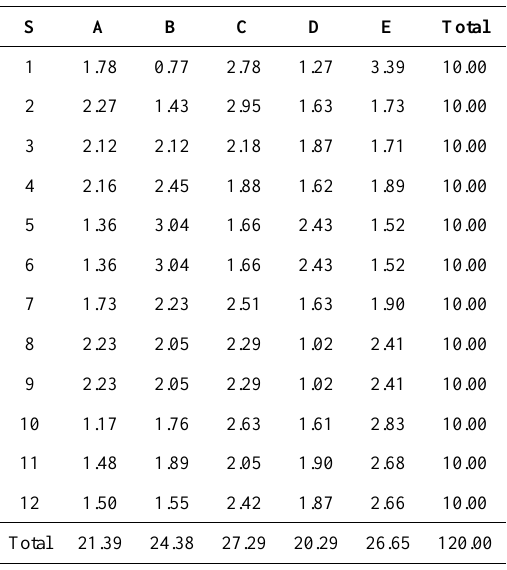
Table 3. Scoring form for the public sector